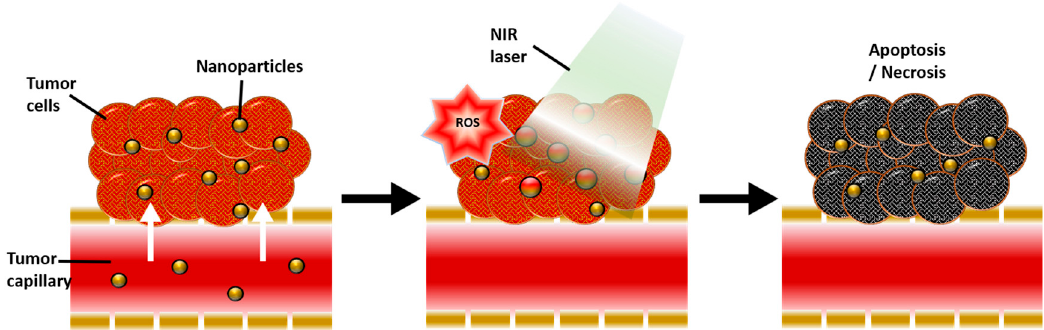
Figure 1. Schematic illustration of the physiological and biological effects of gold nanoparticle-mediated photothermal therapy (PTT) and photodynamic therapy (PDT). A large amount of gold nanoparticles accumulate due to the leaky vasculature of the tumor, resulting in a photothermal effect in response to near-infrared (NIR) light and reactive oxygen species (ROS) generated by secondary delivered photosensitizer (PS), ultimately inducing apoptosis and necrosis of tumor tissue.